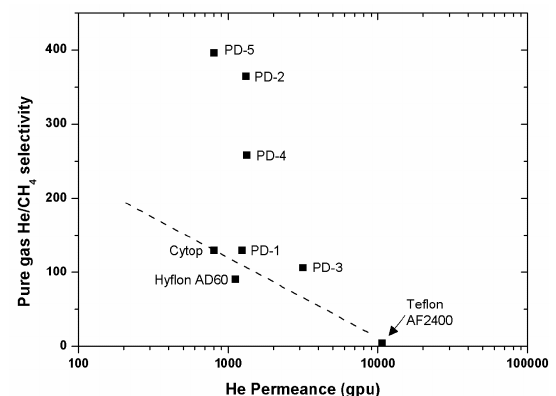
Figure 14. Pure-gas He/CH 4 selectivity as a function of He permeance for various perfluorinated polymer membranes. All data were measured at 22 °C, 50 psig feed pressure, and 0 psig permeate pressure. PD-1: PFMDD- co -PFMD 58:42 mol%; PD-2: PFMMD- co -PFMD 60:40 mol%; PD-3: poly(PFMMD- co -PFMD) 40:60 mol%; PD-4:poly(PFMDD-co-CTFE): 43:47 mol%; and PD-5: poly(PFMMD- co -CTFE) 50:50 mol%.